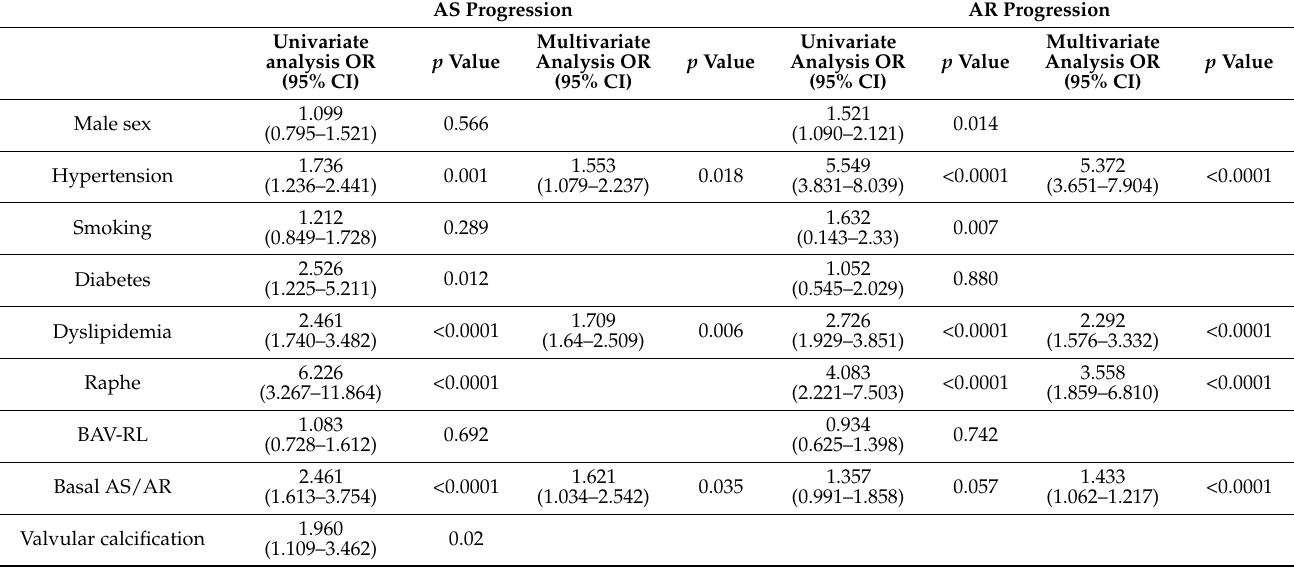
Table 4. Univariate and multivariate analysis of AS and AR adjusted by follow-up